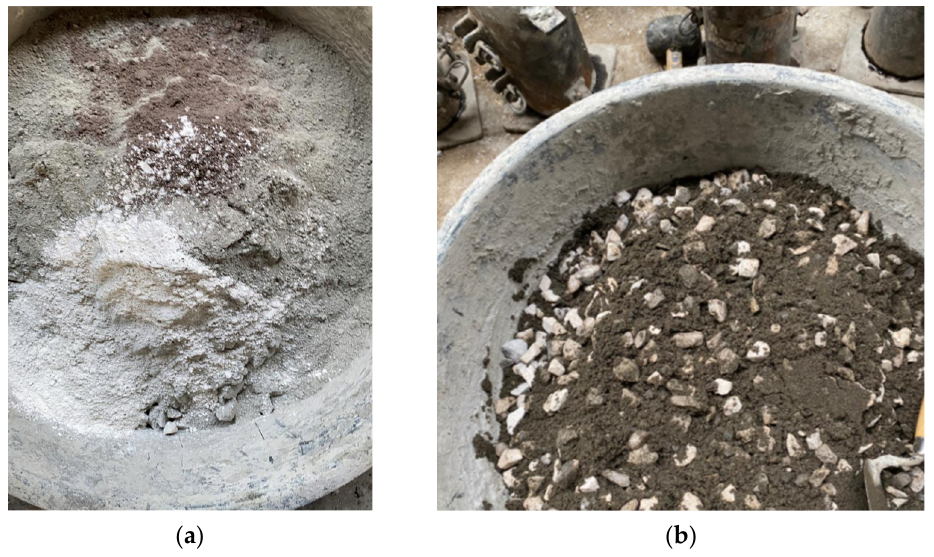
Figure 2. ( a ) Dosing of materials, ( b ) Preparation of the mixture.